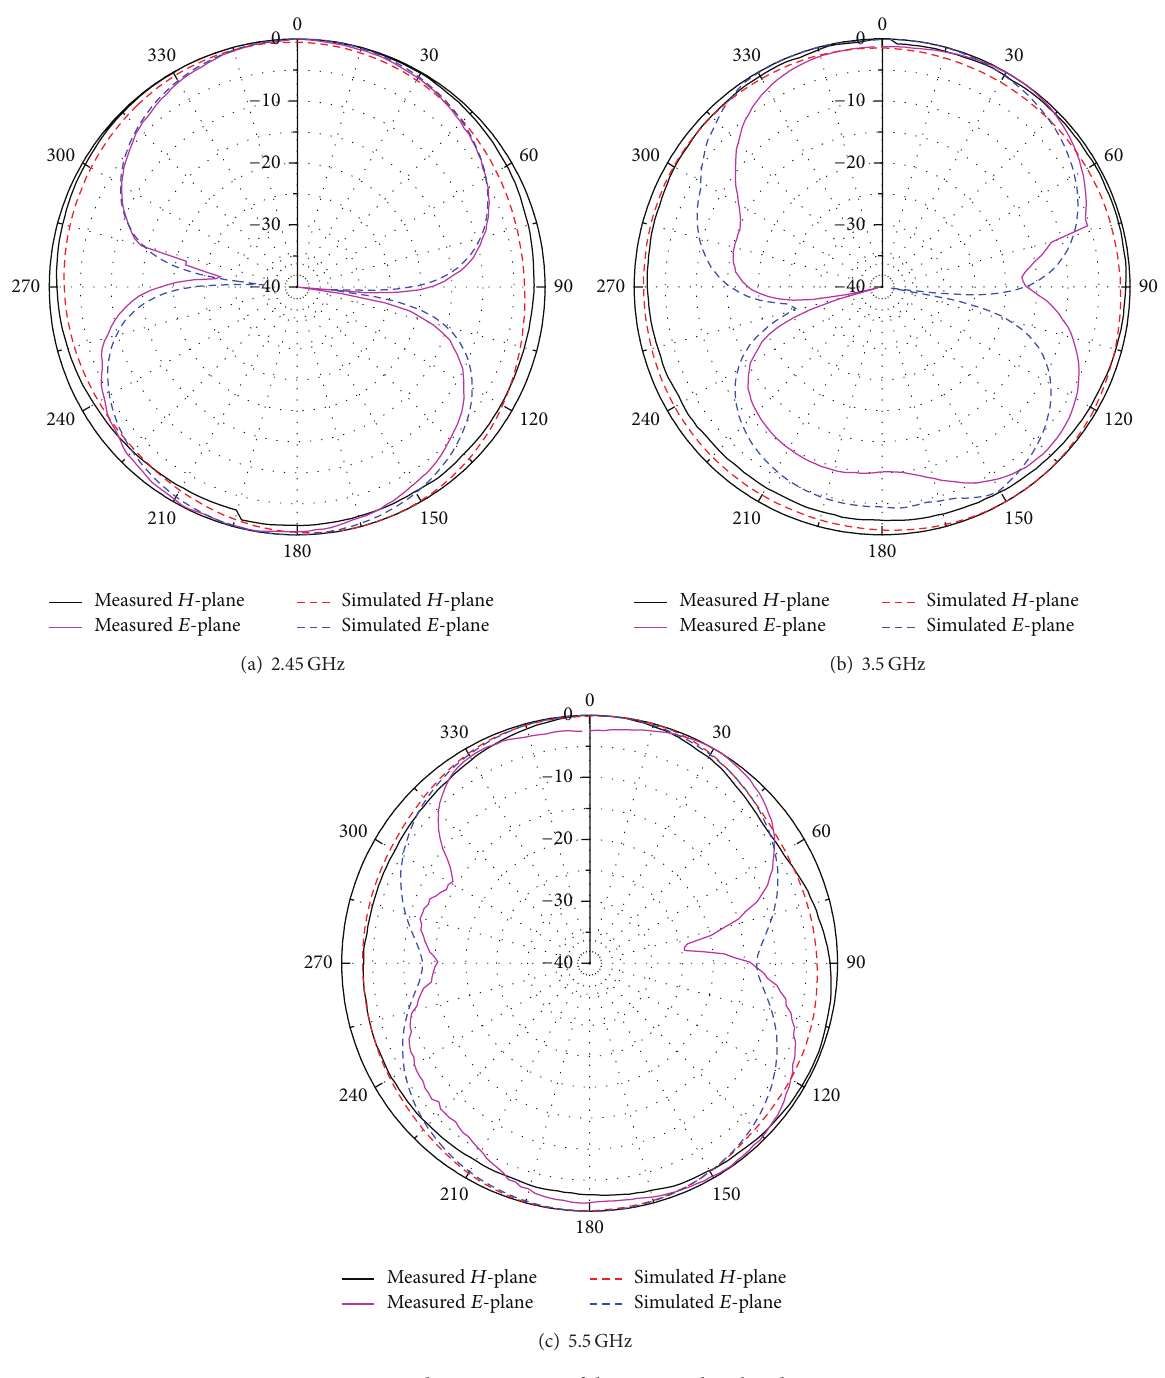
Figure 7: Radiation patterns of the proposed tri-band